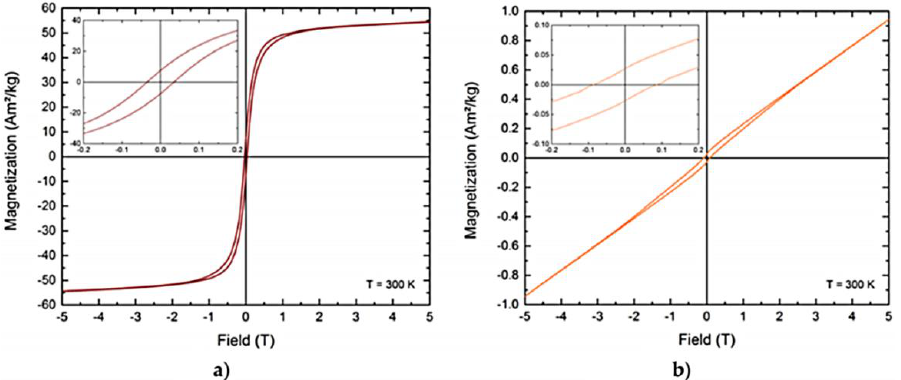
Figure 6. Magnetization curves of FePt nanomaterials. Panel ( a ) ferromagnetic Fe 3 Pt nanocrystals. Panel ( b ) predominantly paramagnetic FePt 3 nanocrystals. Reprinted from [55] (published by MDPI, 2018) licensed under CC BY 4.0.